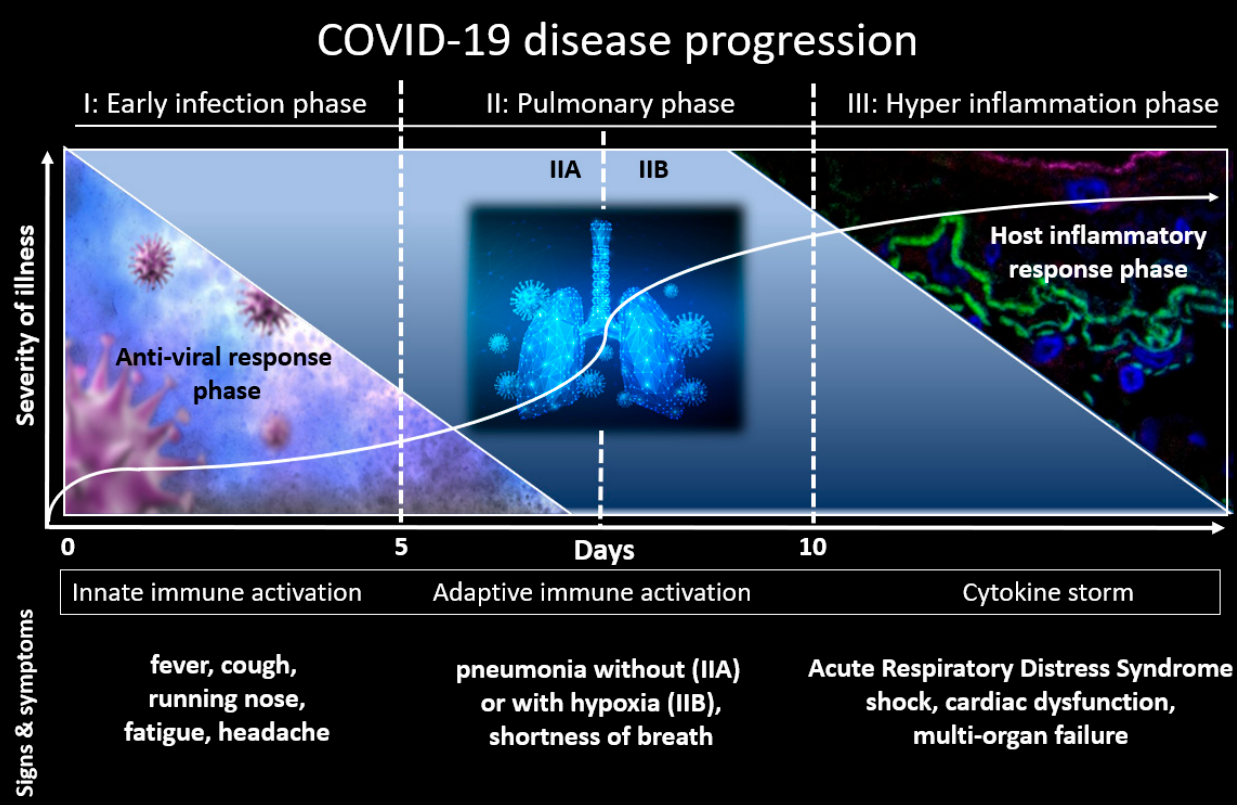
Figure 1. COVID-19 disease progression.